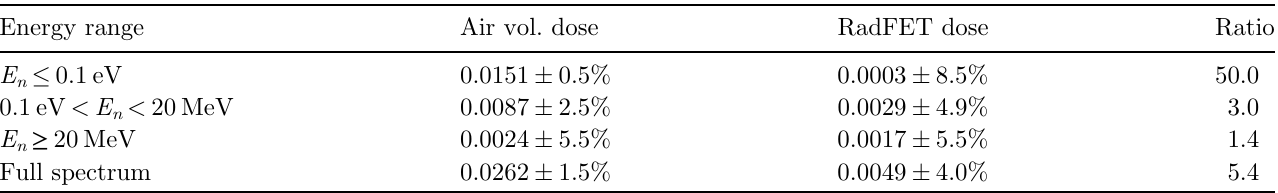
Table 8. Contributions to the total dose deposited in the air cube and the RadFET GO, in 10 (cid:4) 14 Gy/pot, in position 1, due to neutrons at different energies. Energy range Air vol. dose RadFET